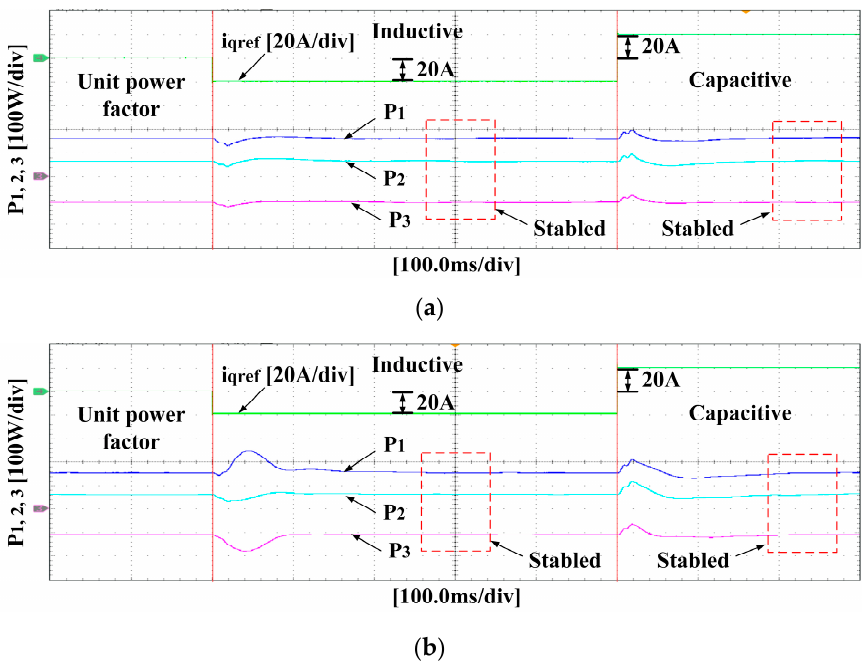
Figure 15. Experimental waveforms of the dc-link voltage of the CHBR modules under different working conditions by use of ( a ) the proposed control strategy and ( b ) the conventional control strat- egy.